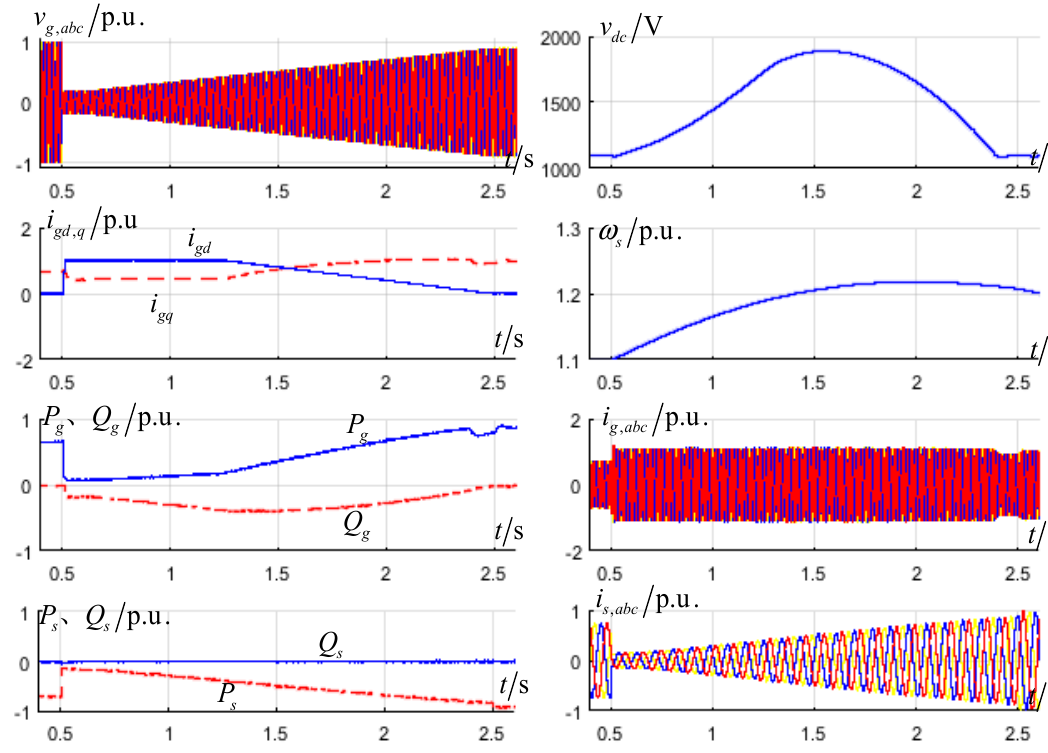
Figure 10. Simulation results of the voltage dips used in the method of [19].